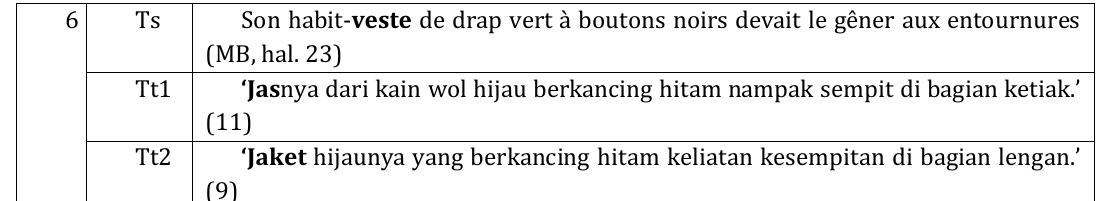
Tableu 6 Le glissement de